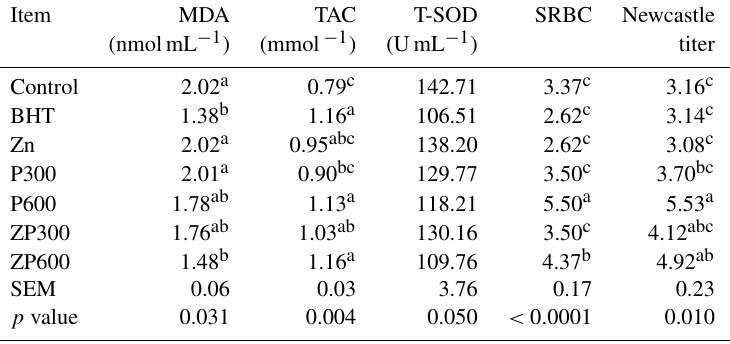
Table 4. Effects of dietary Zn and PHE on the serum concentration of MDA, TAC and T-SOD activity and antibody titers against SRBC and Newcastle virus in broiler chickens.